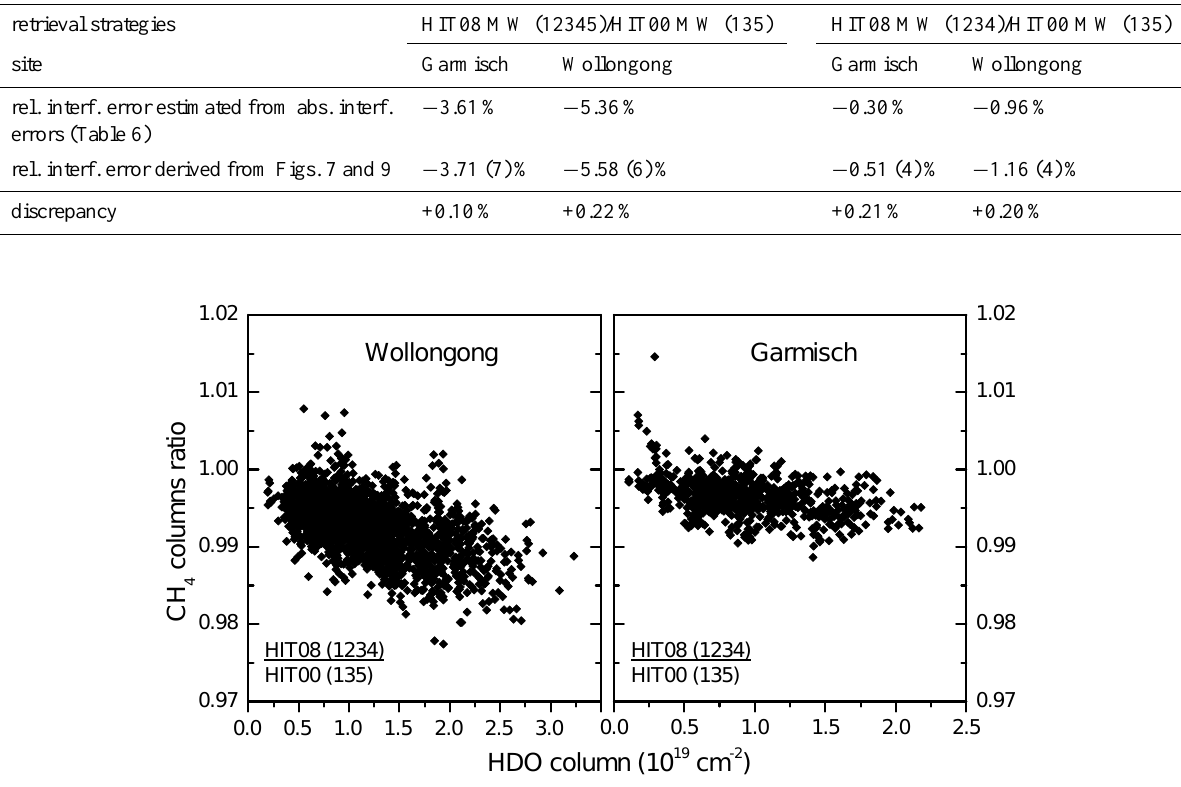
Fig. 9. Ratio plots showing significant relative HDO-CH 4 interference errors which are dominated by the unfavorable HIT08 MW (1234) retrieval strategy while the recommended HIT00 MW (135) retrieval strategy is practically interference free (see Sect.